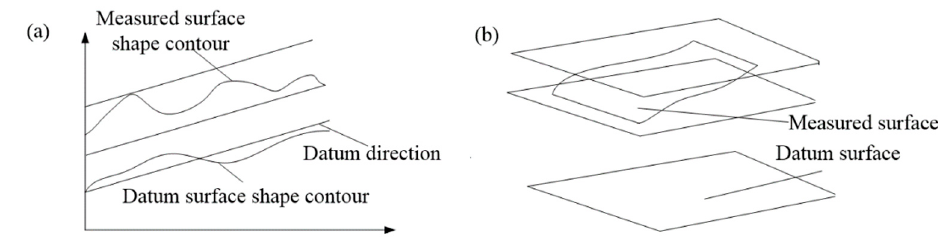
Figure 1. Evaluation method of parallelism: ( a ). Line-to-line ( b ). Surface to surface.